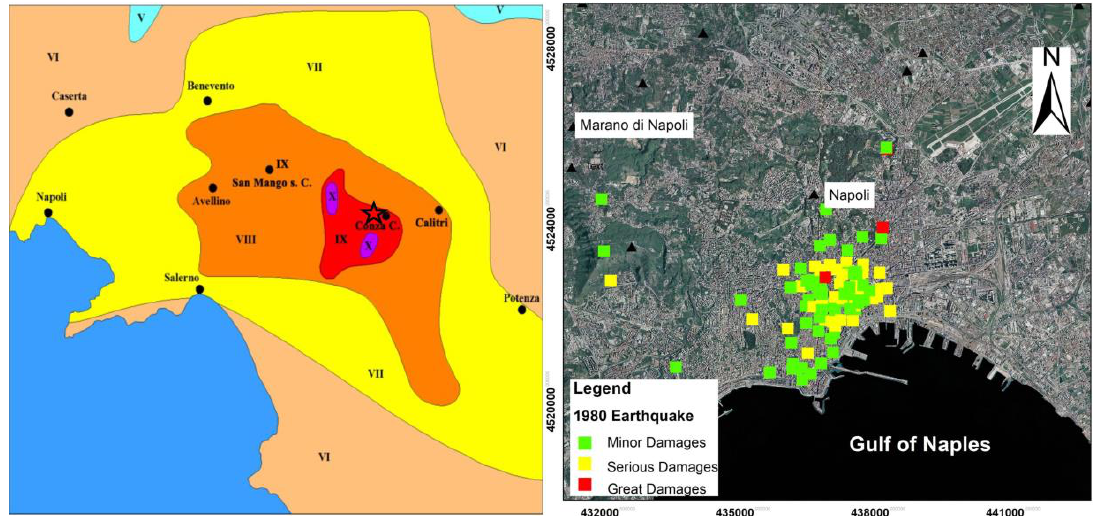
Figure 9. Isoseismal map of the November 1980 Irpinia-Basilicata earthquake [59] (on the left). The different colors are related to the different values of MCS macroseismic intensity, and the black star is the location of the epicenter. Map of the damage caused in Naples by the earthquake on 23 November 1980 (on the right).